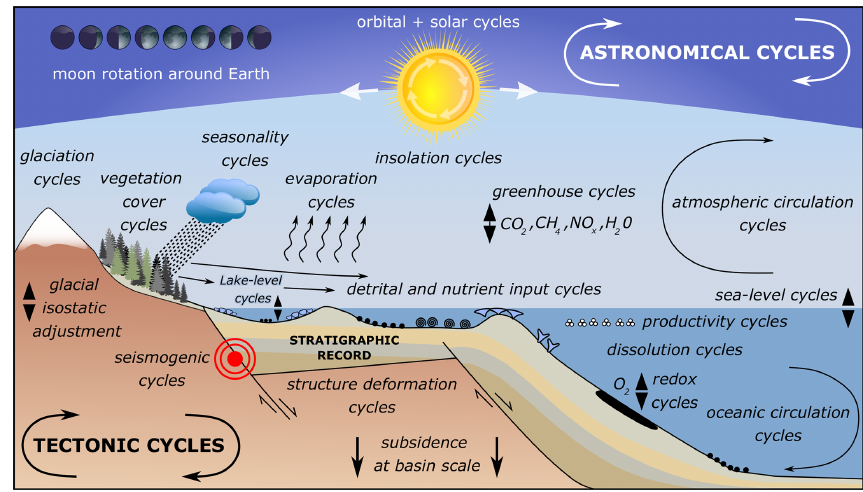
Figure 17. Schematic diagram illustrating the main allocyclic controls on sedimentation (modified from Strasser et al.,